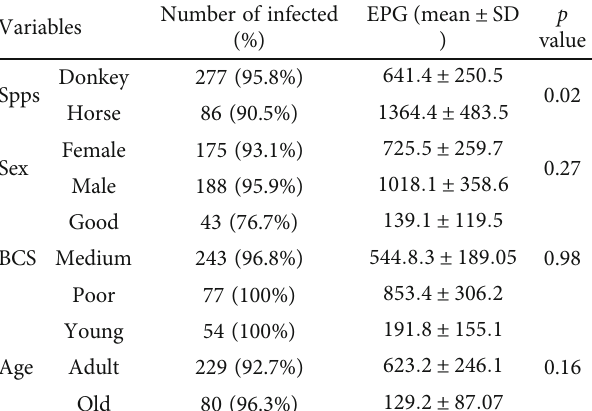
Table 6: Fecal egg count of GIT nematode in